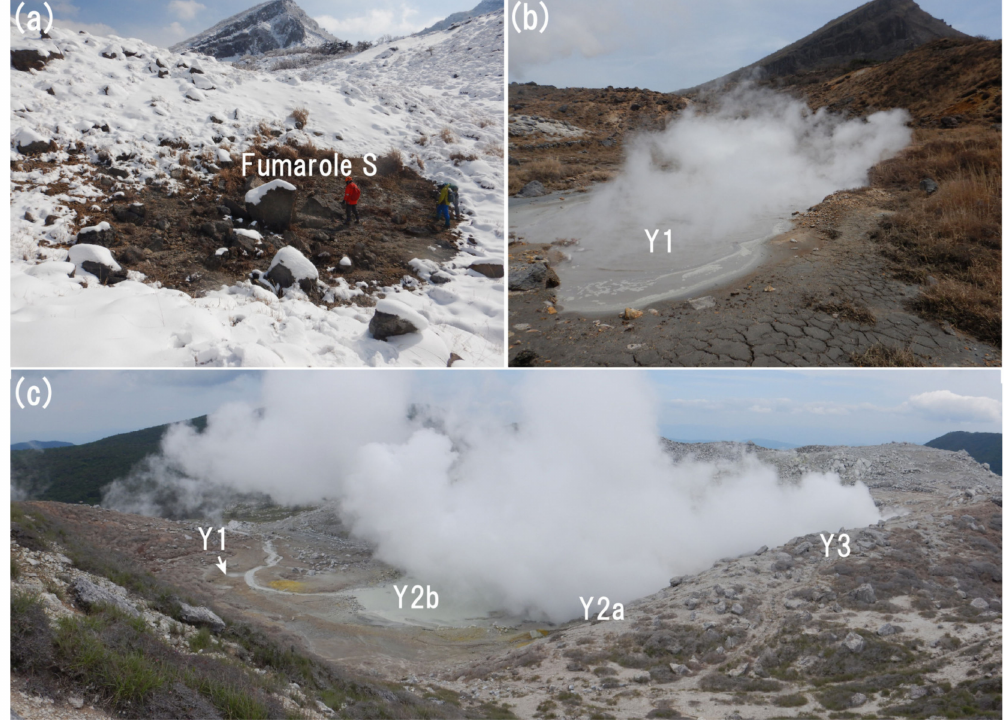
Figure 7. Photos showing the geothermal activity around Ioyama-fumarole area in 2018. ( a ) New fumarole S appeared at the south side of Ioyama-fumarole area (Photo on 3 February); ( b ) Hydrothermal pond Y1, 9 m long and 5 m wide that formed on 7 April (Photo on 16 April); ( c ) Distribution of craters of the steam driven eruption on 19 April (Photo on 4